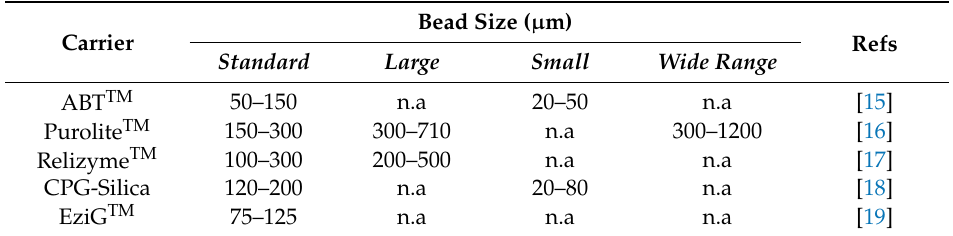
Table 1. Bead size distribution of commercial carriers for protein